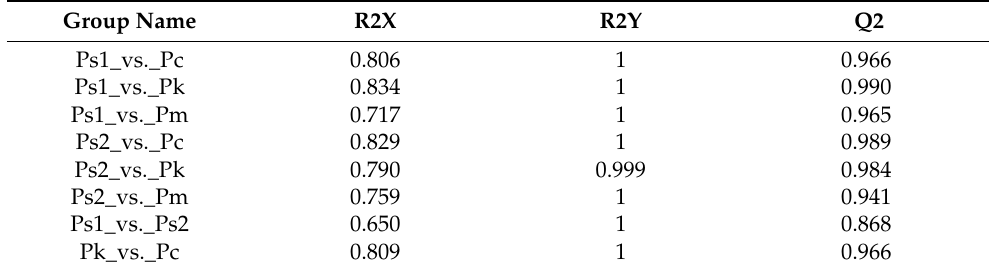
Table 3. OPLS-DA parameters for predicting differentially abundant metabolites.